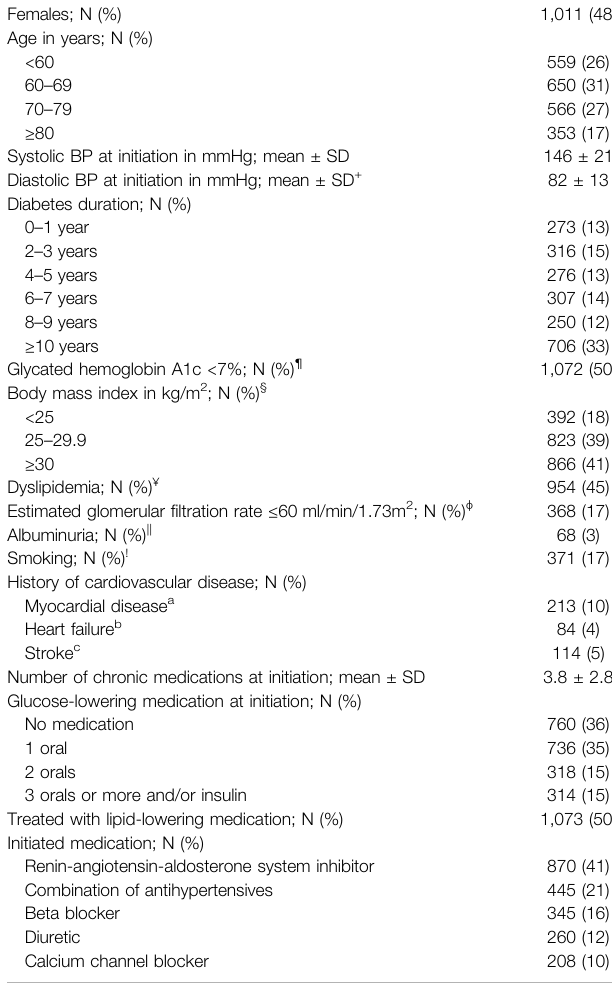
analyses ( N = 2,128). Females; N